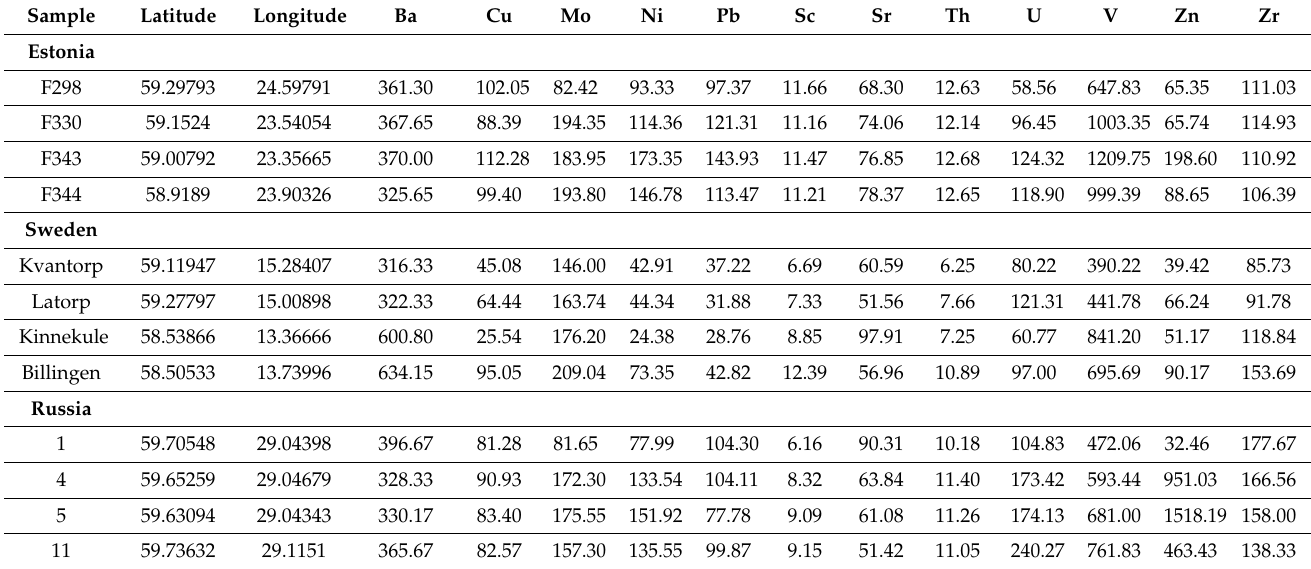
Table 2. Average trace element concentrations (in ppm) of representative black shale drill cores in Estonia and Russia, and outcrops in